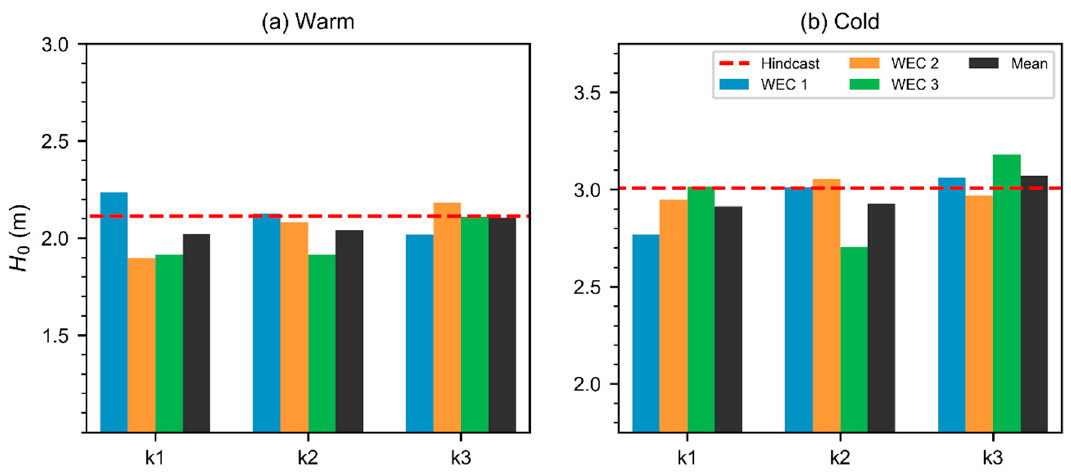
Figure 7. Significant wave height values computed from FUNWAVE post-processed spectra for the case of ( a ) warm weather and ( b ) cold weather months, compared to hindcast benchmarks.